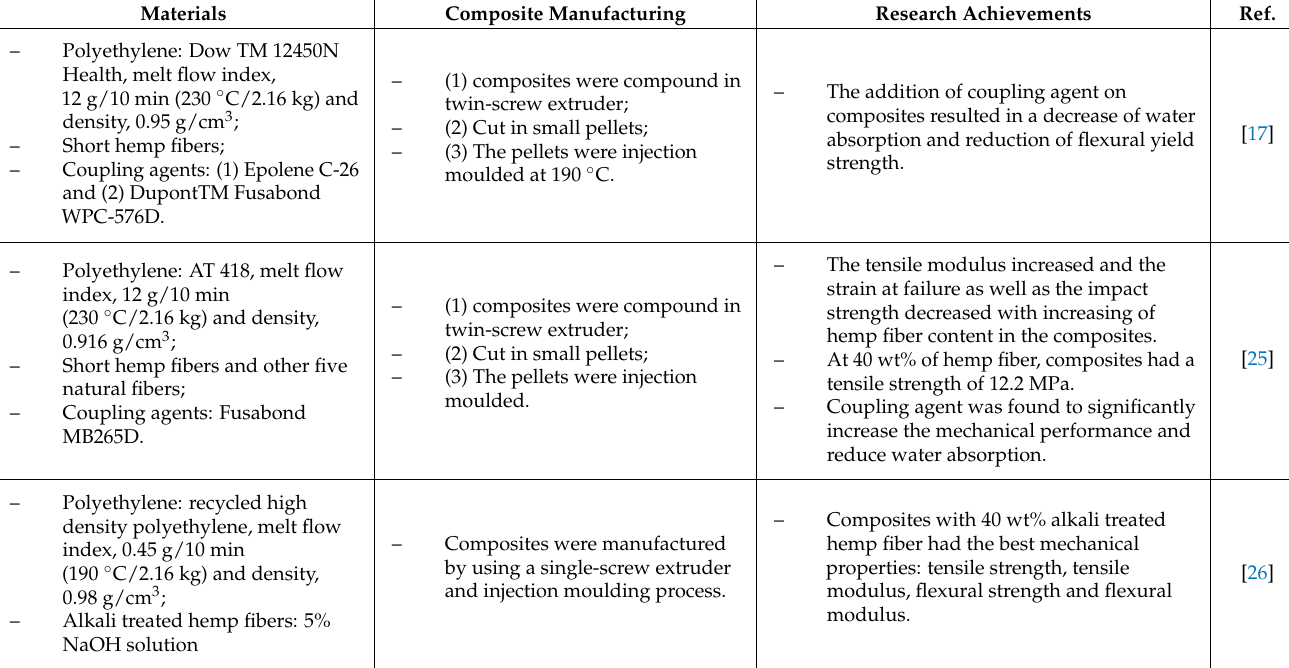
Table 2. Literature review on hemp fiber reinforced polyethylene composites, based on injection mould production.